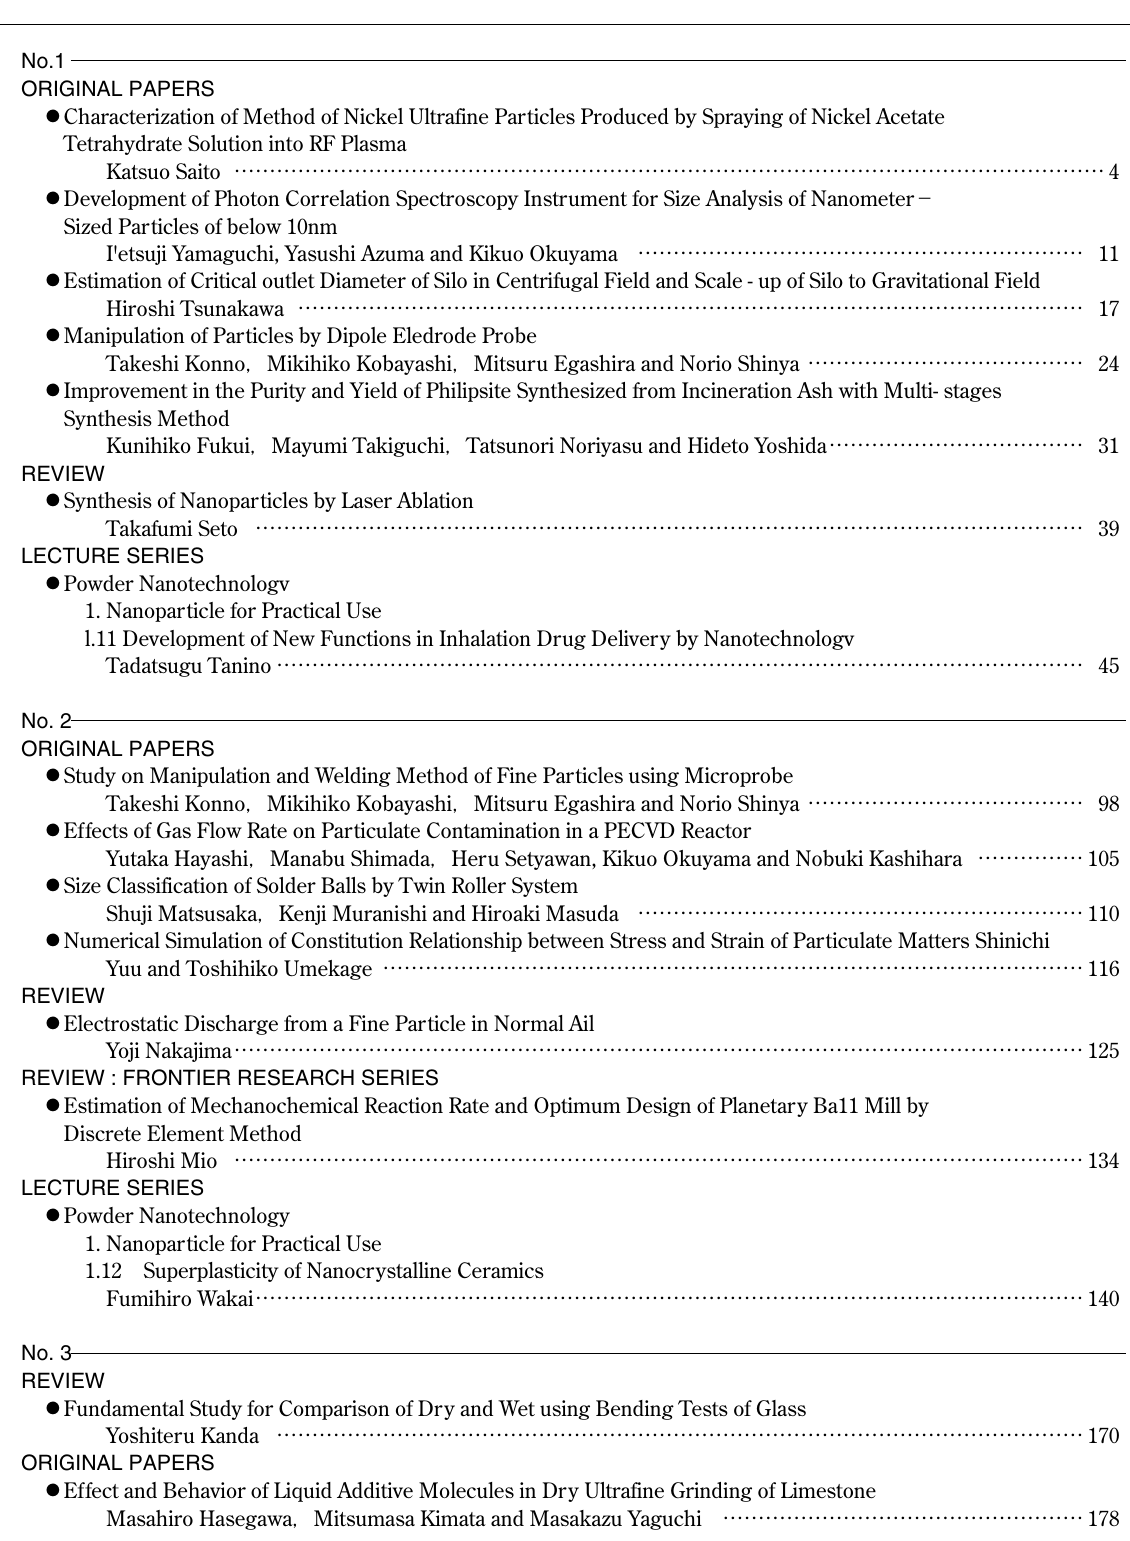
・ Manipulation of Particles by Dipole Eledrode Probe Takeshi Konno ， Mikihiko Kobayashi ， Mitsuru Egashira and Norio Shinya ………………………………… 24 ・ Improvement in the Purity and Yield of Philipsite Synthesized from Incineration Ash with Multi- stages Synthesis Method